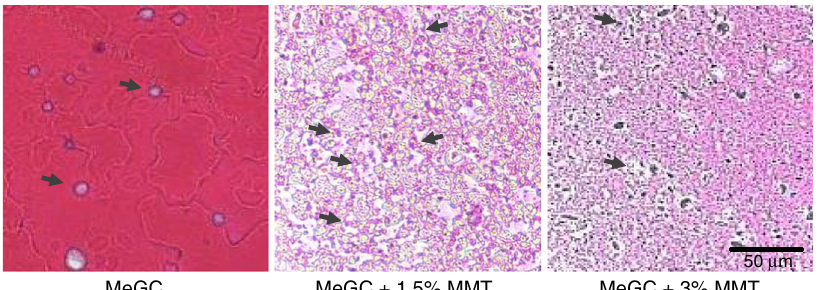
Fig. 4 Hematoxyline and eosin (H&E) staining of encapsulated cells in photocross-linked MeGC-MMT nanocomposite hydrogels with various amount of MMT (0%, 1.5%, 3%). The hydrogels were cultured for 7 days ( n = 3), scale bar = 50 μ m, arrows indicate the cells